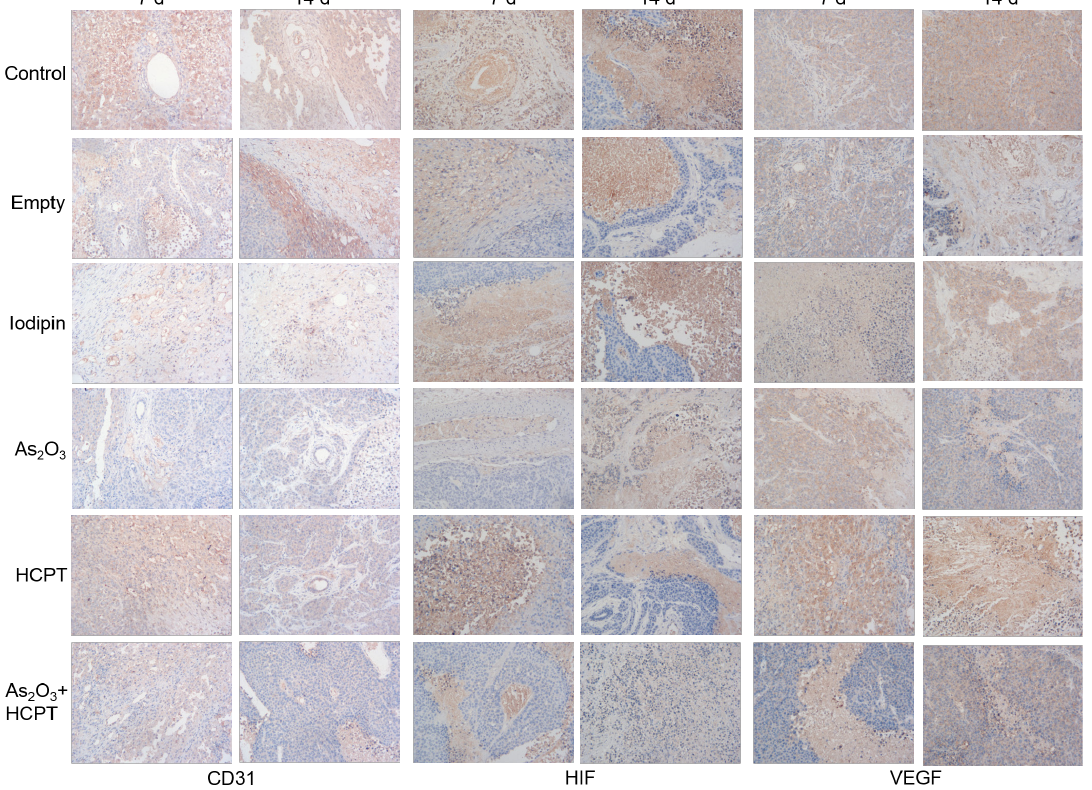
Fig. 4. Immunohistochemical detection of the effects of combined embolization of PLGA microspheres loaded with HCPT and As O on CD31, HIF and VEGF expression 2 3